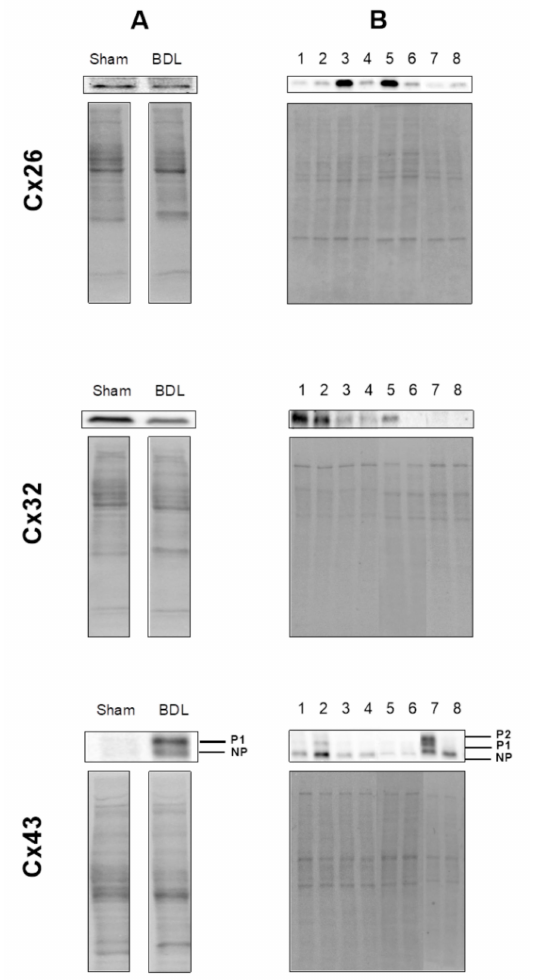
Figure 8. Total protein loading of samples used in immunoblot analysis. Semi-quantitative immunoblot analysis of Cx26, Cx32 and Cx43 in liver of cholestatic mice ( A ) and in human hepatoma HepaRG cells cultured in cholestatic conditions ( B ) was performed. For Cx43, both the phosphorylated (P) and non-phosphorylated (NP) variant could be detected. Signals of the three connexins were normalized against total protein loading, which are shown for two representative samples. ( A ) Liver sections were obtained from male mice following bile duct ligation (BDL) for 20 days (Sham n = 12; BDL n = 18) (N = 1). ( B ) Human hepatoma HepaRG cells were exposed to cholestatic drugs either in the absence or presence of a 50 × concentrated mixture of bile acids (BA) for 72 h and compared to untreated human hepatoma HepaRG cells, indicated in the figure as control. The di ff erent experimental conditions are presented in the figure as: 1 = control ( n = 3); 2 = control BA ( n = 3); 3 = atazanavir (ATV) ( n = 3); 4 = ATV BA ( n = 3); 5 = cyclosporine A (CsA) ( n = 3); 6 = CsA BA ( n = 3); 7 = nefazodone (NEF) ( n = 3); 8 = NEF BA) ( n = 3) (N =